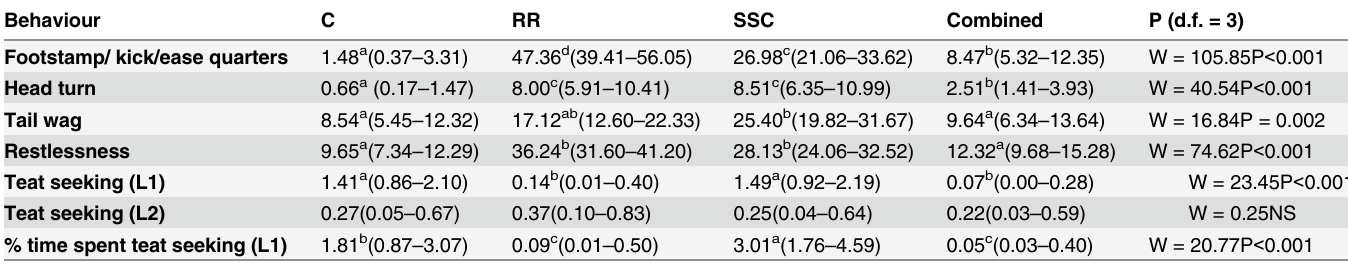
Table 4. The effect of different methods of castration on the expression of lamb pain-related behaviours in the first 30 minutes following treatment. Behaviour C RR SSC Combined P (d.f. =